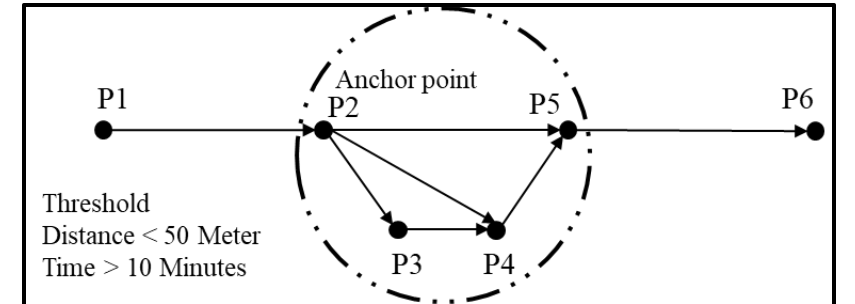
Figure 5. Stay point extraction.